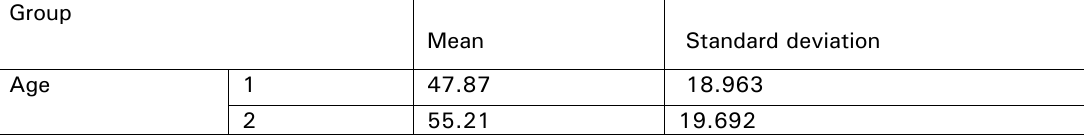
Table no 3. Mean age undergoing surgery